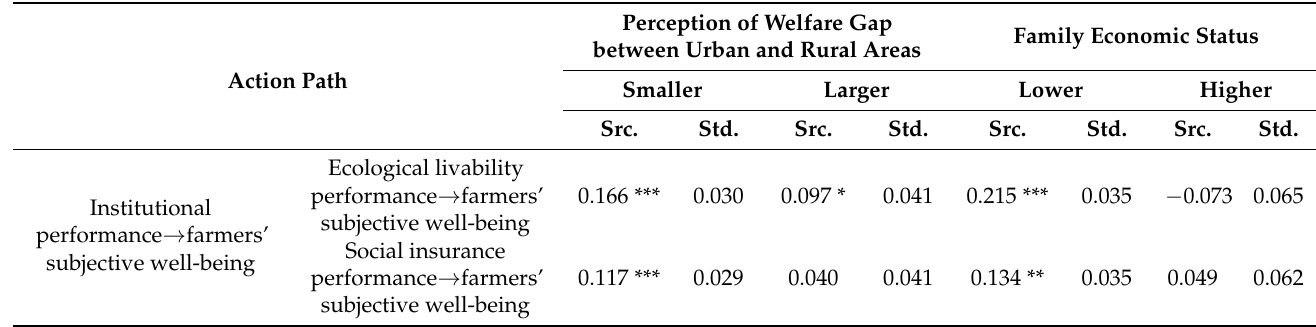
Table 7. Moderating effect results and testing.